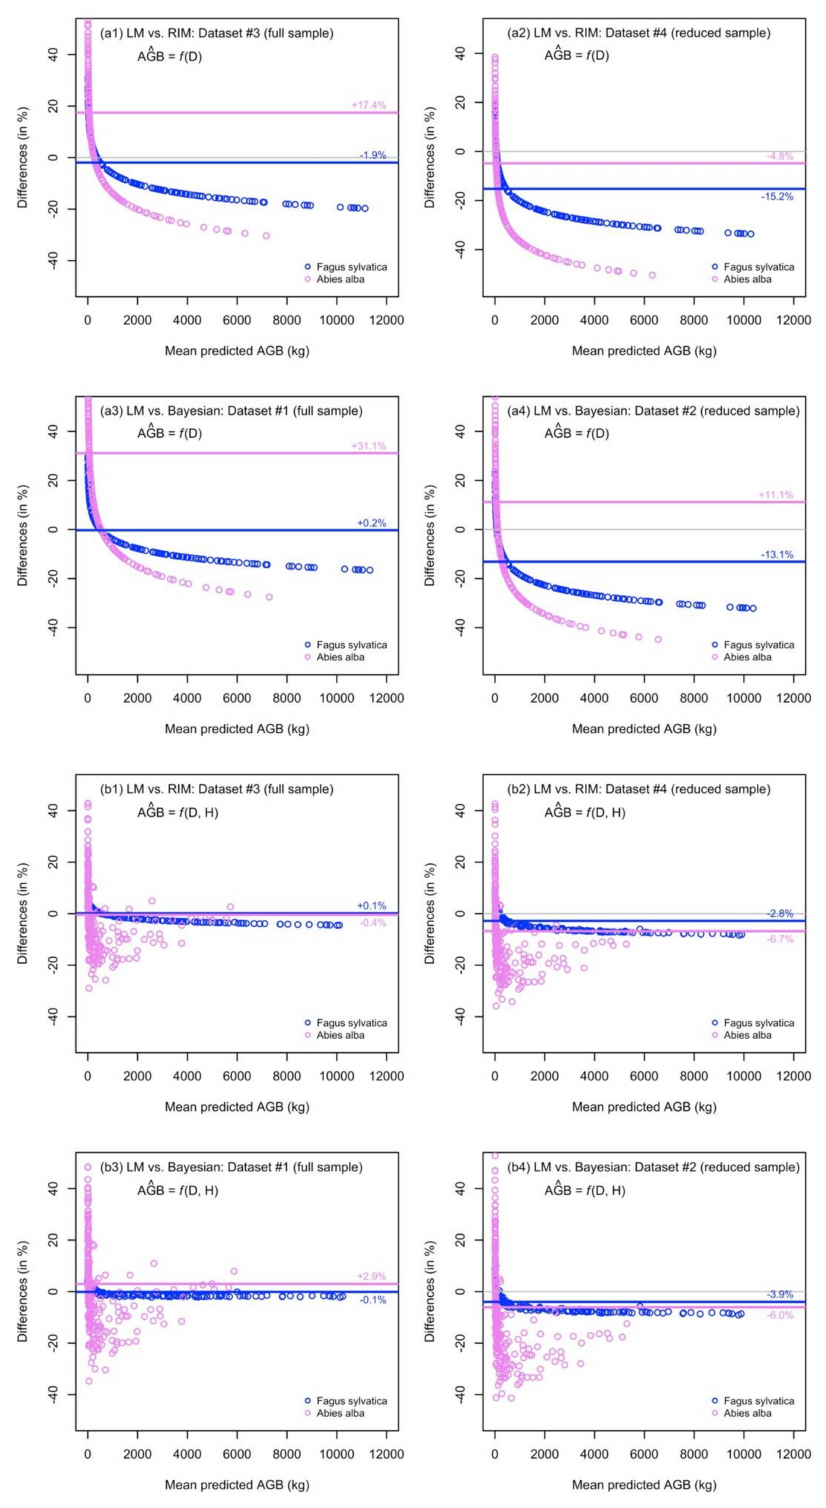
Figure 2. The Bland-ltman plots comparing individual tree AGB predictions. Note: the mean di ff erences are calculated as the mean of relative individual di ff erences (not di ff erences between sum of individual AGB